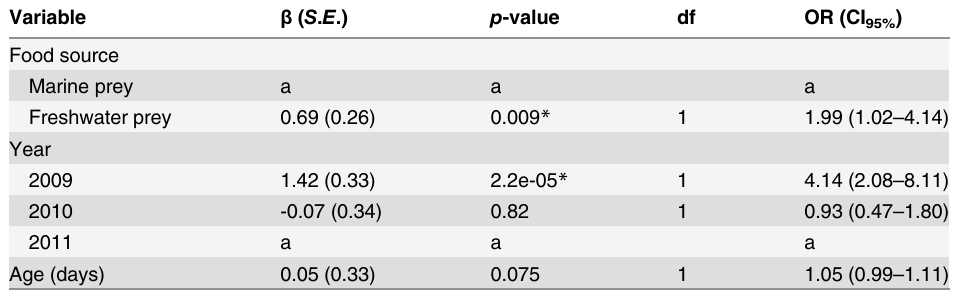
Table 2. Results of the generalized linear mixed-effects model of risk factors associated to Toxo- plasma gondii seroprevalence in seagulls in